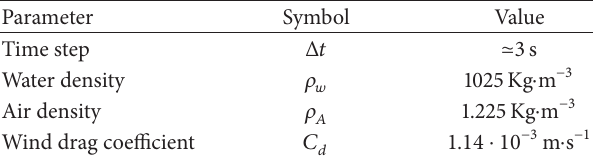
Table 1: Parameters of the hydrodynamic